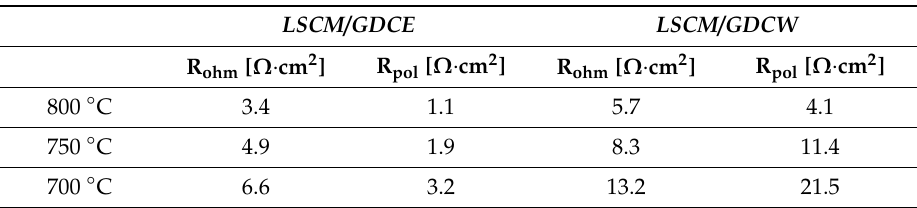
Table 1. R ohm and R pol values of both cells operating in CO/CO 2 =30/70 mixtures at different temperatures.